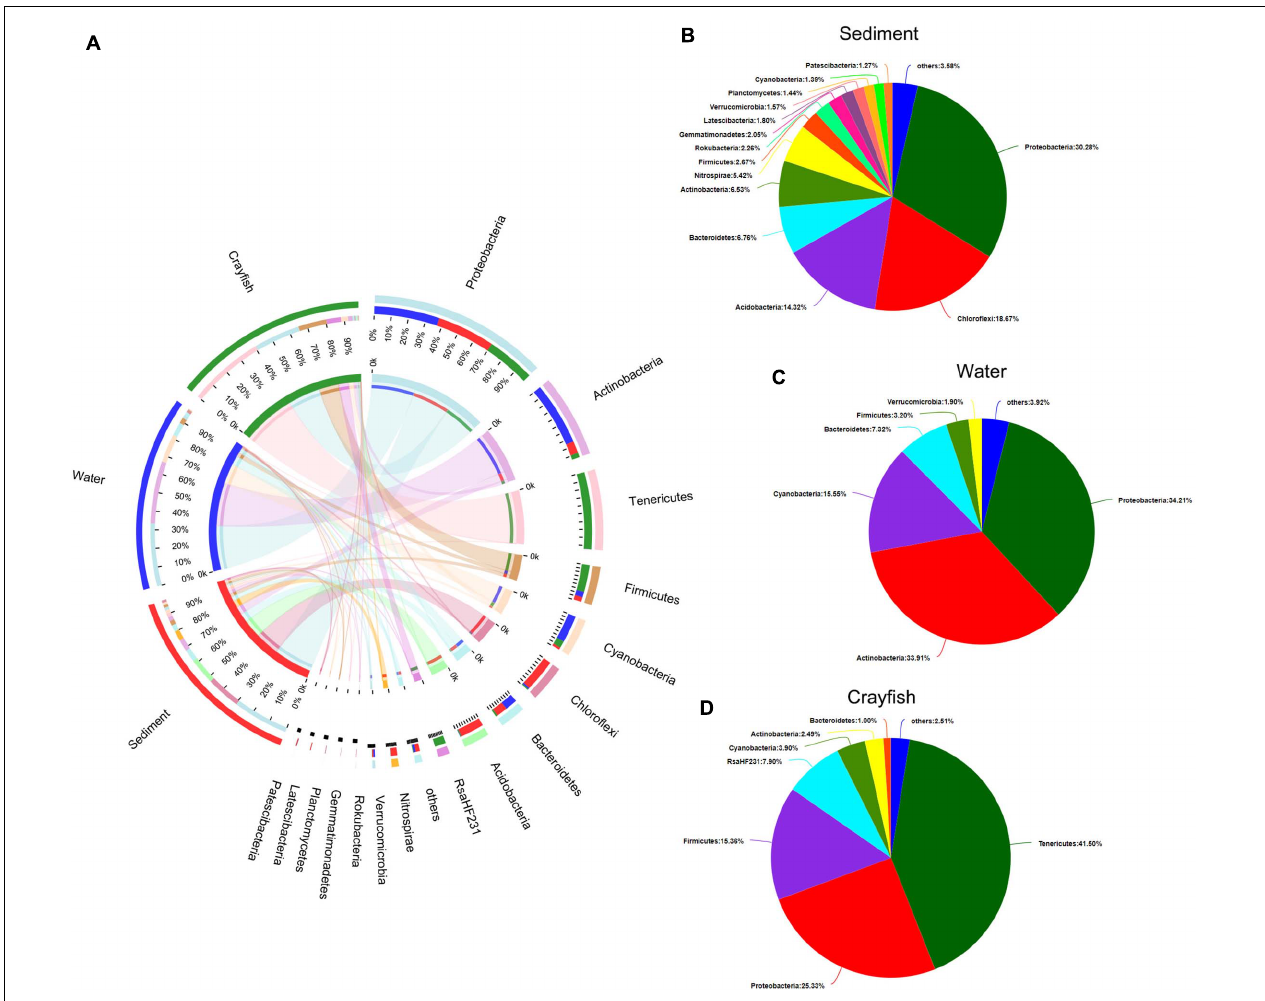
FIGURE 2 | Phylum-level composition of the bacterial community in the sampling groups. (A) Distribution of phyla within the microbial community of each sample. The width of the bar of each phylum indicates the relative abundance of that phylum in the sample. (B) Composition of the bacterial community in sediment. (C) Composition of the bacterial community in water. (D) Composition of the bacterial community in crayfish intestine. Low abundance sequences (i.e., < 1% abundance) were combined and specified as